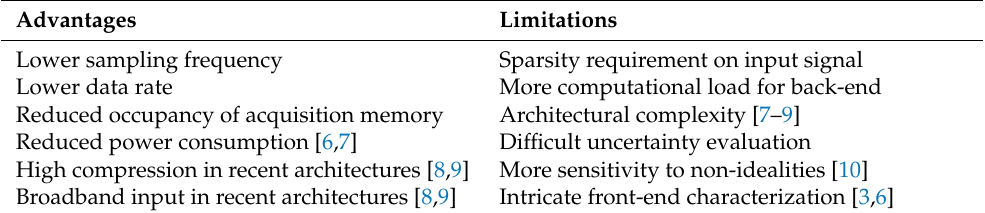
Table 1. AIC-based measurement instrumentation: advantages and limitations.